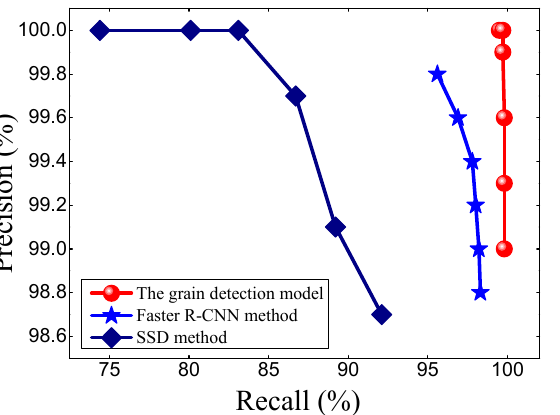
Figure 5. The Precision-Recall curve of the grain detection model compared with the original Faster R-CNN method and SSD method.